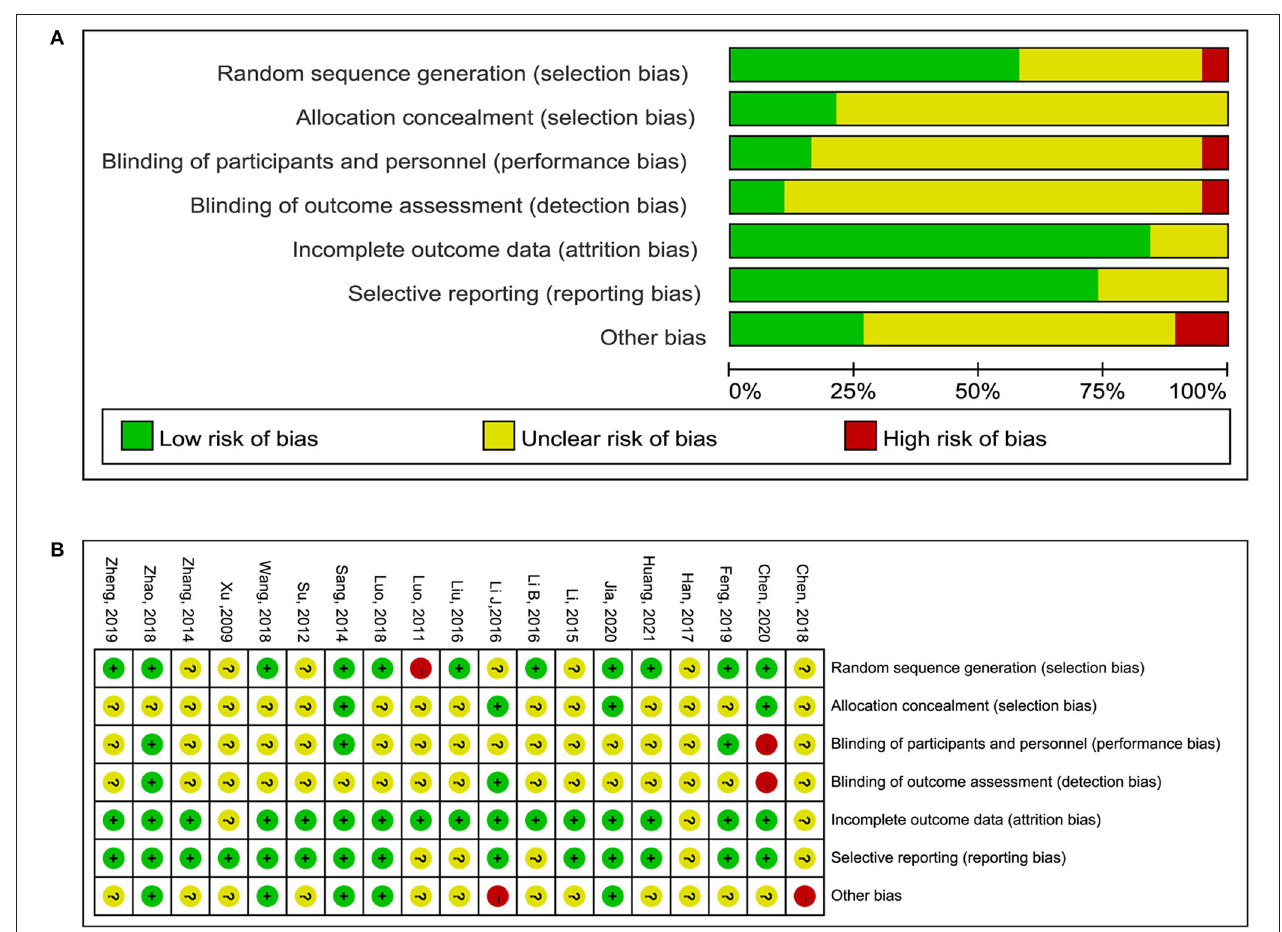
FIGURE 2 | Risk of bias graph. (A) Risk of bias item presented as percentages across all included RCTs. (B) Risk of bias item for included